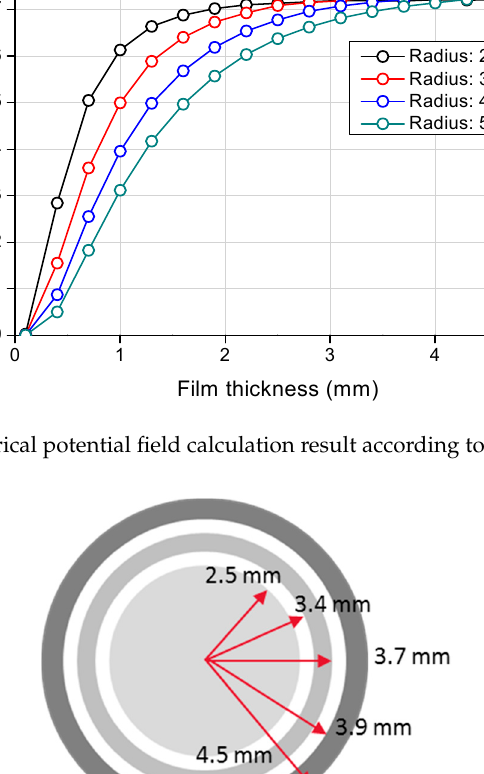
Figure 5. ( a ) Calculation domain of the electrical potential analysis; and ( b ) electrical potential field around the electrodes